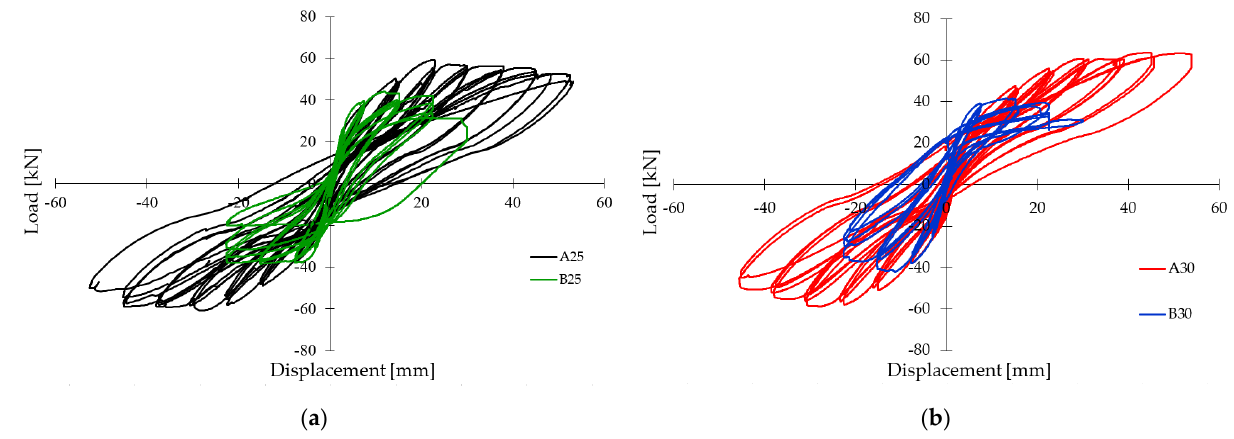
Figure 3. Experimental test results; ( a ) un-corroded A25-corroded B25 specimens; ( b ) un-corroded A30-corroded B30 specimens.